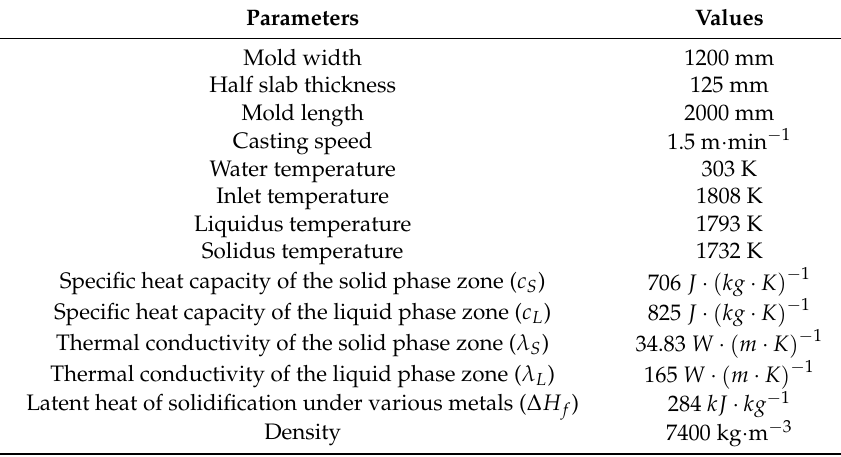
Table 3. Simulation constants for solidification